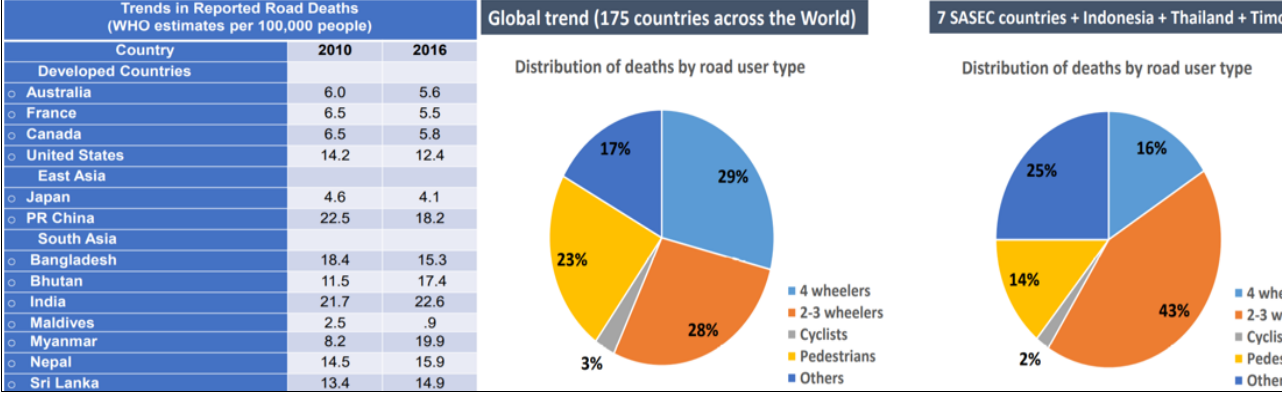
Figure 18: WHO 2018 Global Status Report on Road Safety. Source: [1].